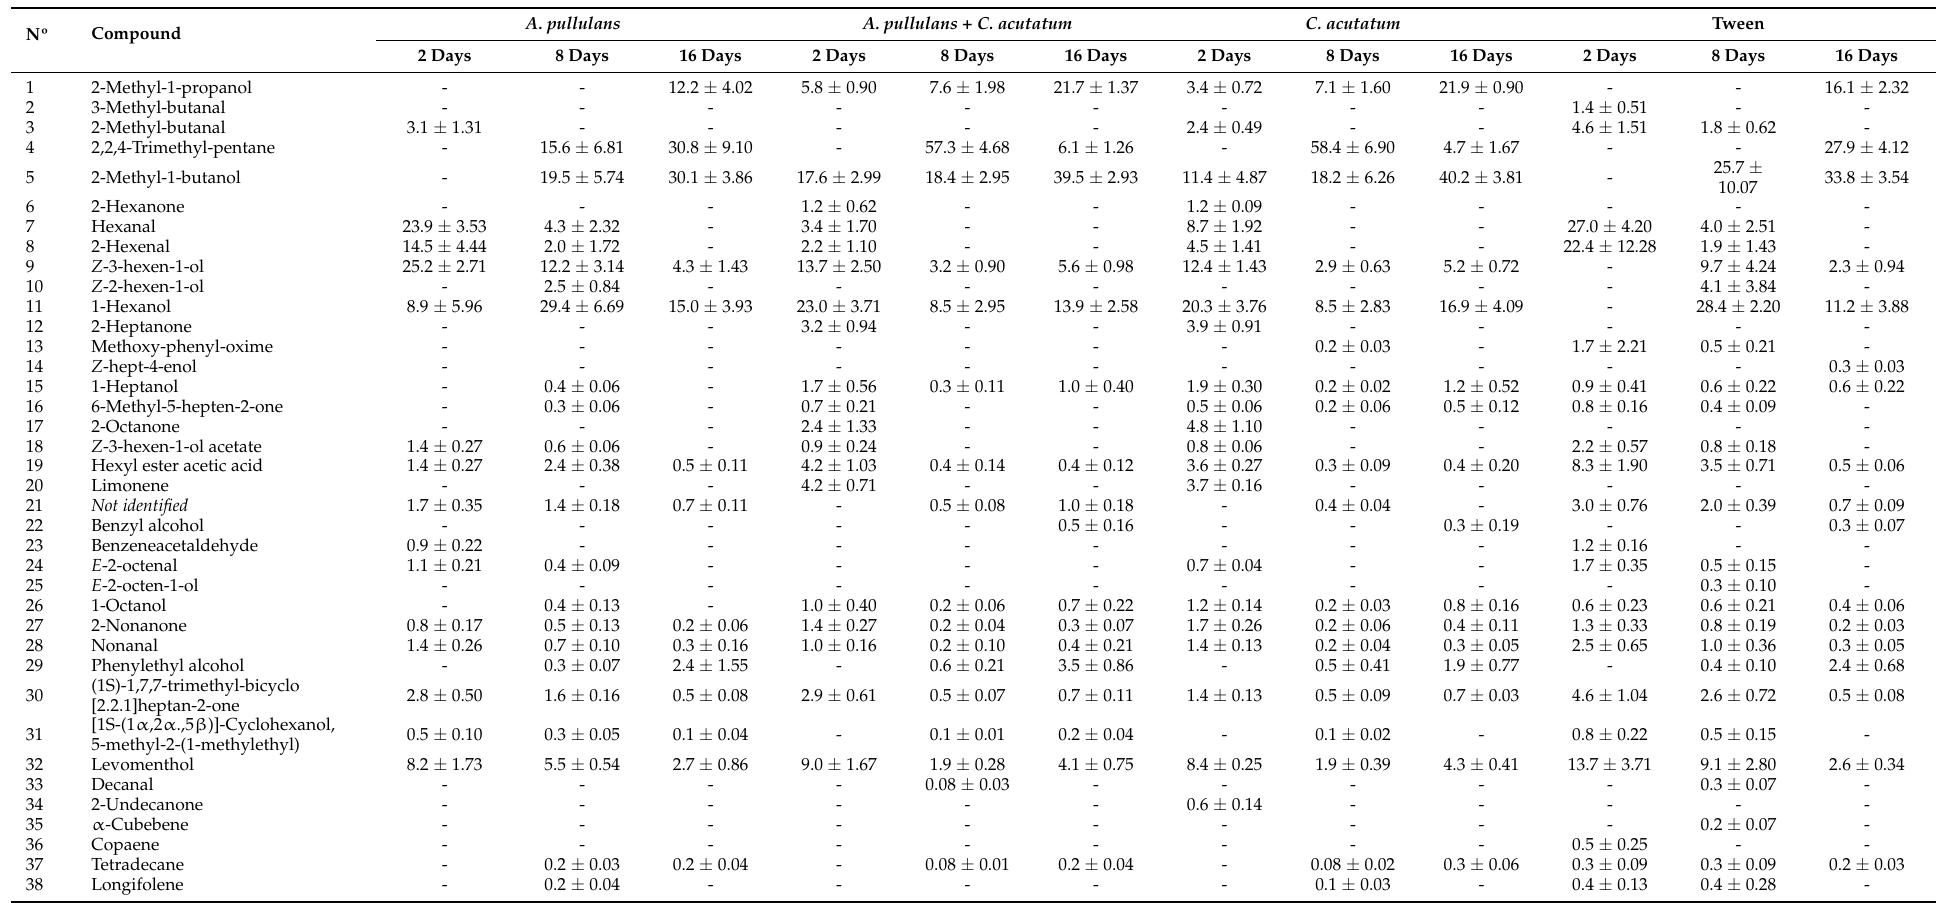
Table 1. Volatile profile of olives inoculated with Aureobasidium pullulans and Colletotrichum acutatum ( A. pullulans + C. acutatum ), or solely with A. pullulans , C. acutatum or Tween (controls), 2, 8 and 16 days after pathogen inoculation. Results are expressed in relative percentage of the total chromatogram area (mean ± standard deviation, n =